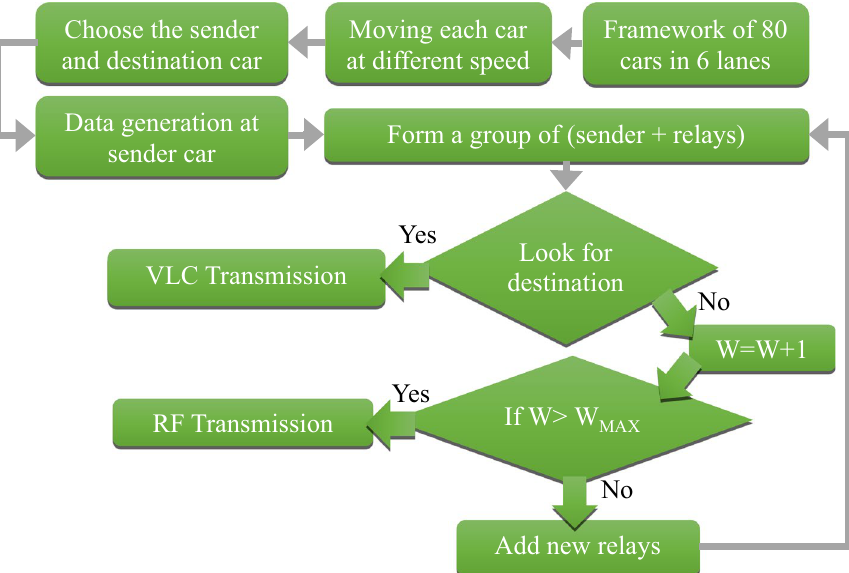
Fig. 3 The proposed scheme flowchart. The proposed flowchart builds a framework of the road and randomly allocates 80 cars within the road. Then, set a random speed for each car and choose one car and sender and another as the receiver. The generated data in the sender car try to communicate with the receiver through VLC single hop. Then, the car increases the number of hops if it fails to close the connection. However, in some weather conditions, the VLC communication cannot succeed. Then, if the maximum number of hops is reached, the scheme switches the communication type to